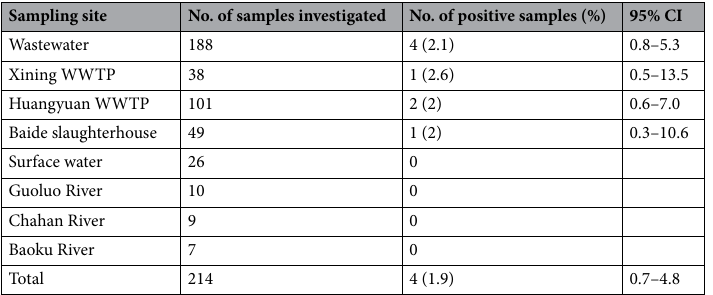
Table 1. Summarized results on the detection of Toxoplasma gondii DNA in water and wastewater samples collected from different sources in Qinghai Province, P.R. China using real-time